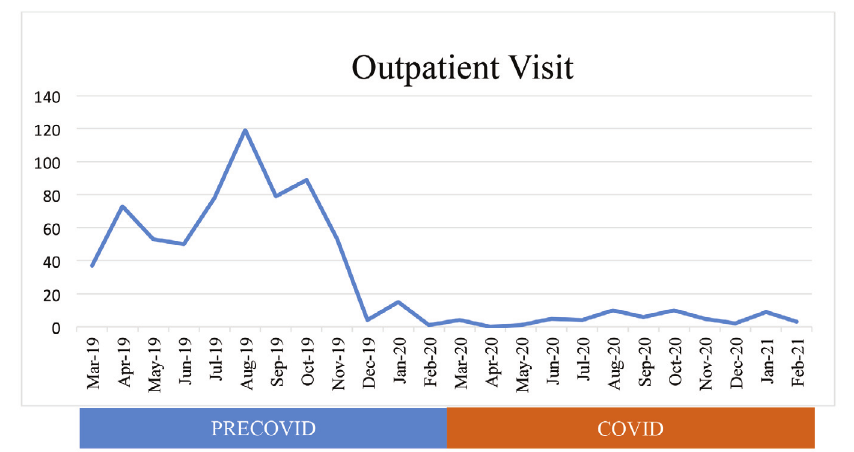
Fig. 2: Total outpatient visit in the lower extremity section of the Prof. Dr. R. Soeharso orthopaedic hospital.